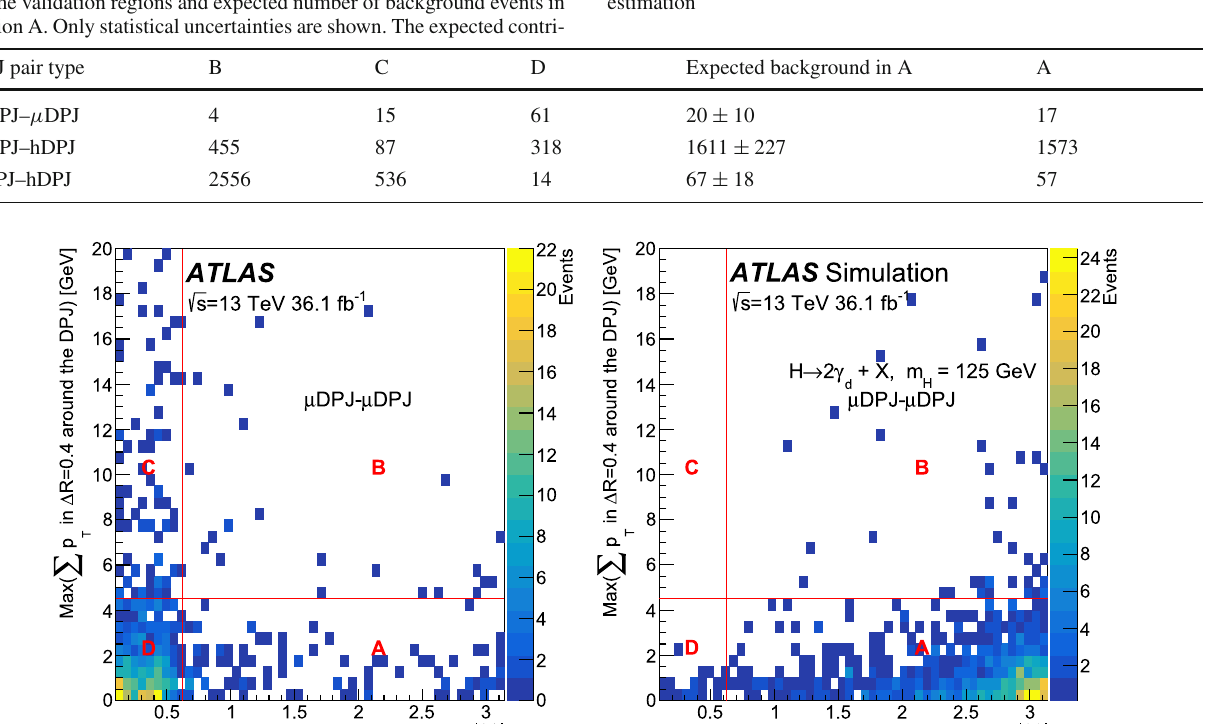
bution from cosmic rays is included in all regions and in the background estimation